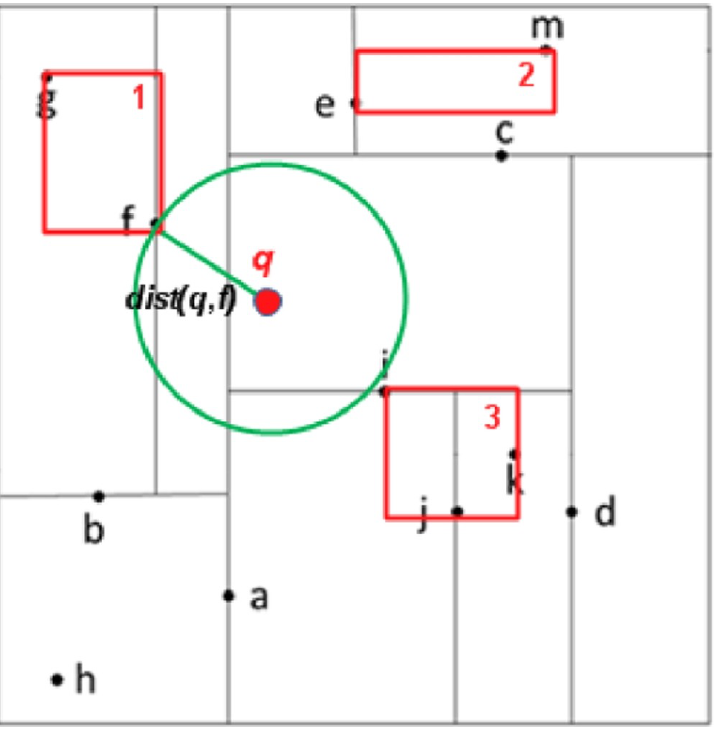
Figure 6. KD-TREE search